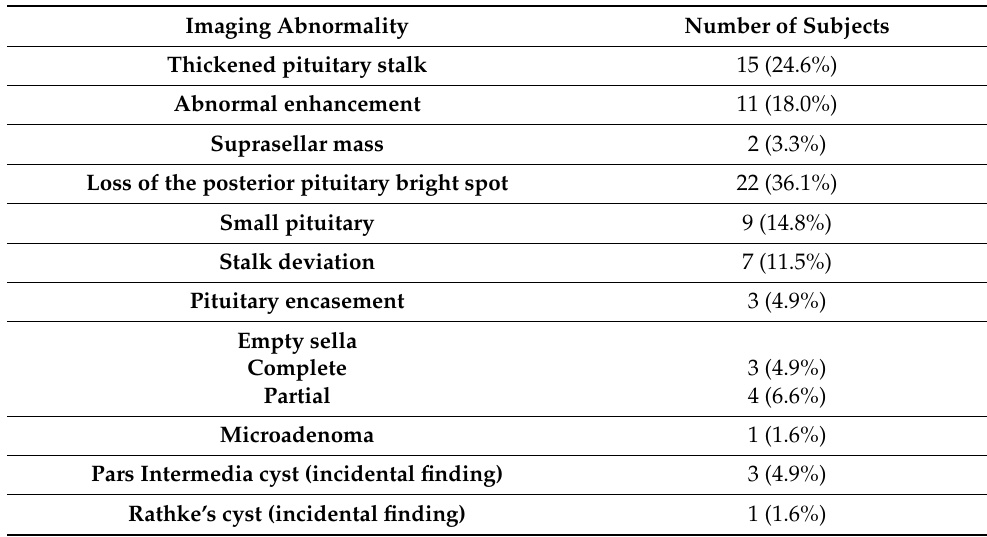
Table 2. Pituitary imaging findings and their frequencies. Cumulative number of subjects with imaging abnormalities do not match the study number ( n = 61) because several subjects had more than one imaging abnormality while others had normal pituitary